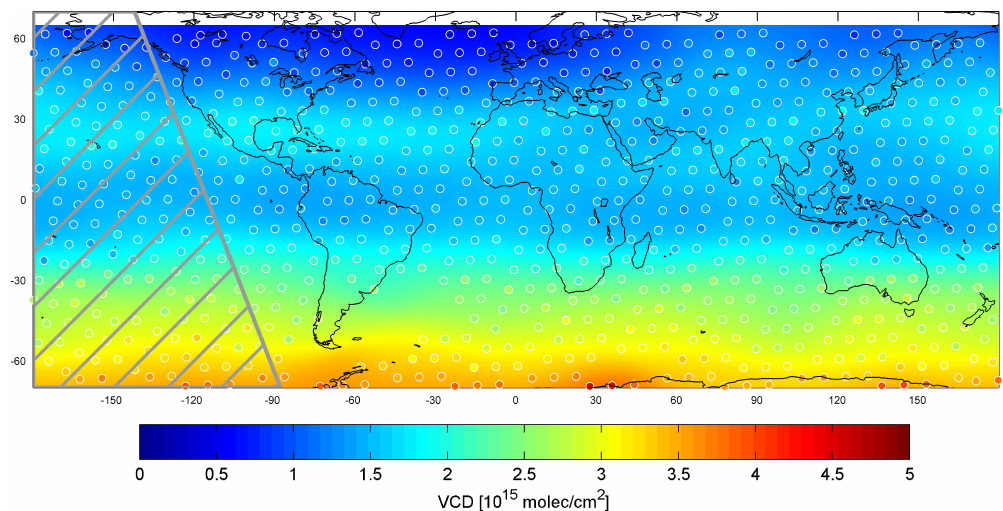
Fig. 2. Stratospheric VCD L derived from integrated limb profiles 27–29 January 2006. Colour-coded disks indicate the location of the tangent points for the individual limb VCDs L , the map shows the interpolated and smoothed field b L(d,3,φ)